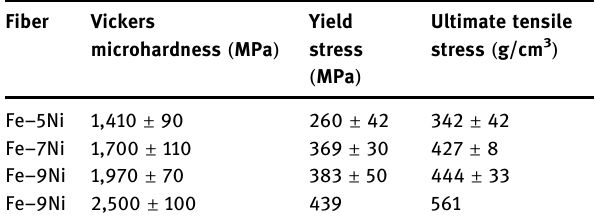
Table 3: Properties of several metal - matrix